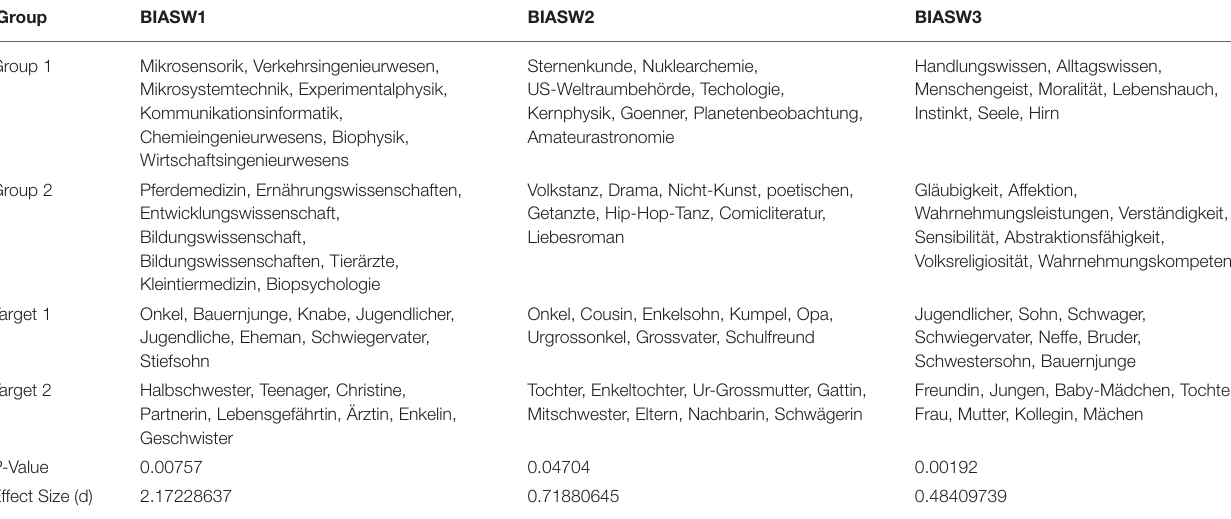
TABLE 9 | Results of the new word sets created with the BiasWords method and its validation using the WEAT method.